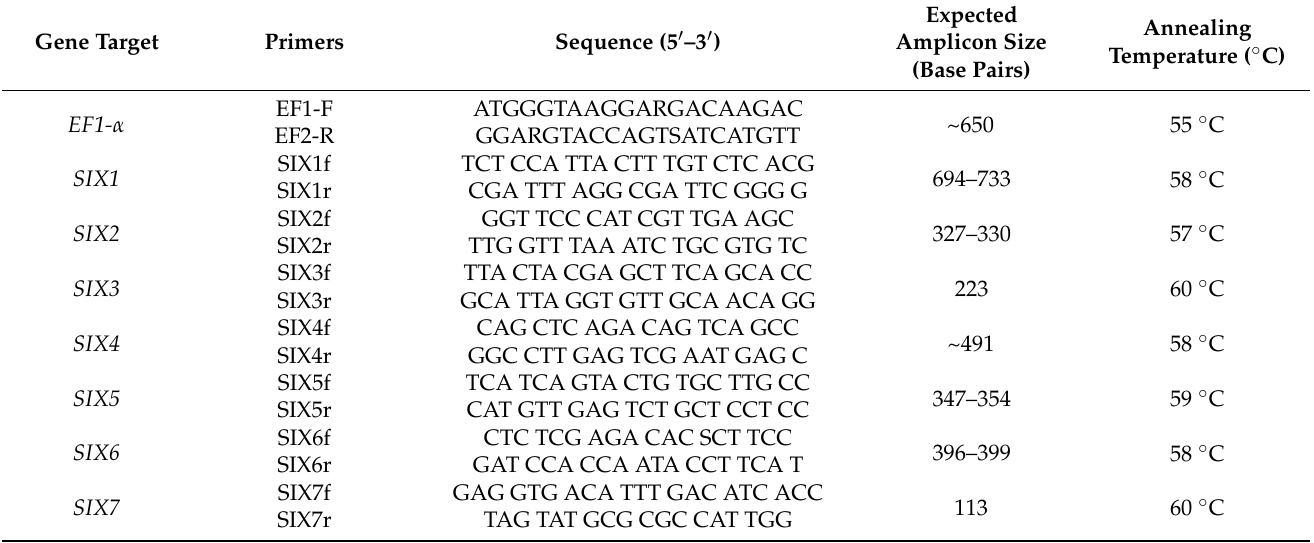
Table 4. PCR primers used in this study, including the expected amplicon size and annealing temperature for the primers. Primers for the translation elongation factor 1- α ( EF1- α ) were as described by O’Donnell et al. [19]. Universal primers for the SIX genes were all designed as part of this